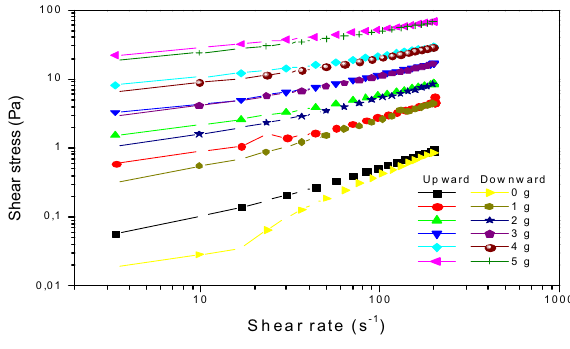
Fig. 9 Thixotropic behavior of drilling muds for different quantities of VG69 organophilic